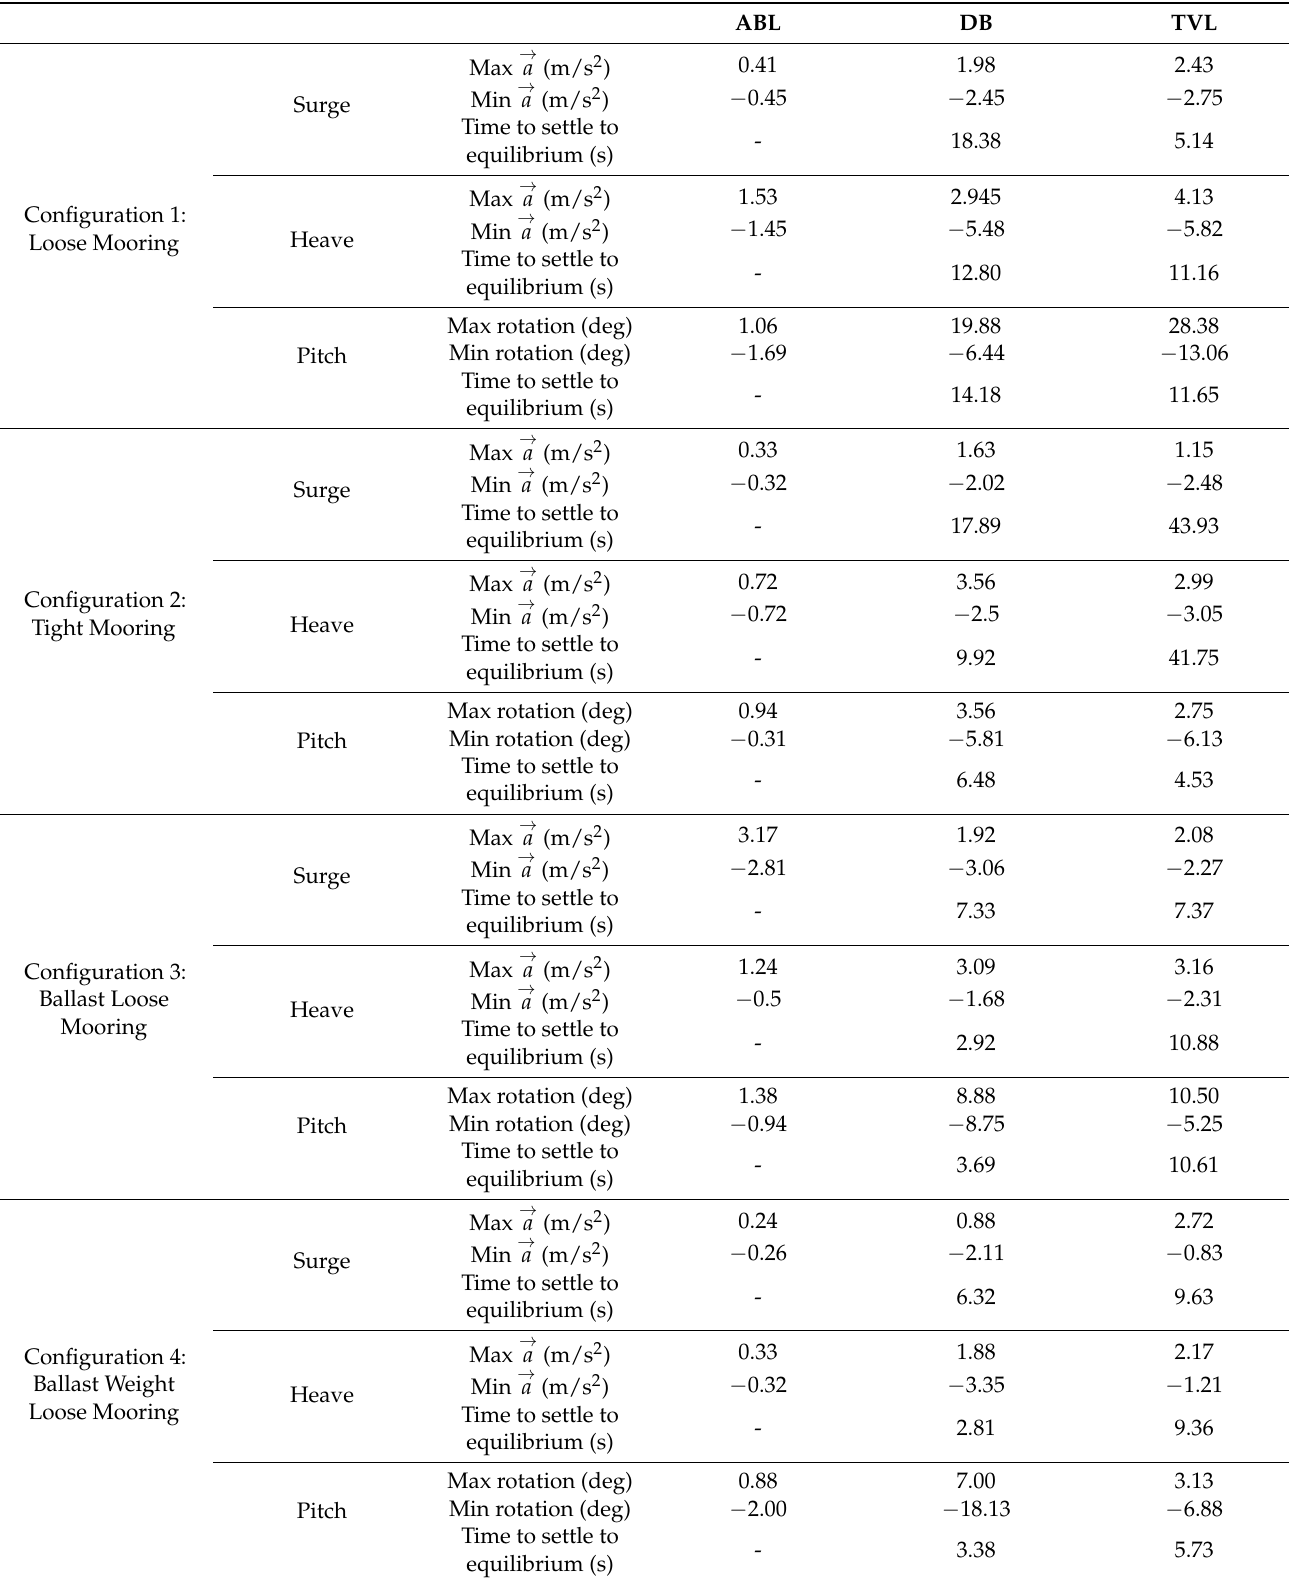
Table A1. Summary of the maximum and minimum heave, pitch and surge accelerations, as well as the time it took for the structure to result to the equilibrium position after the completion of the downburst wind subject, and end of the tornado